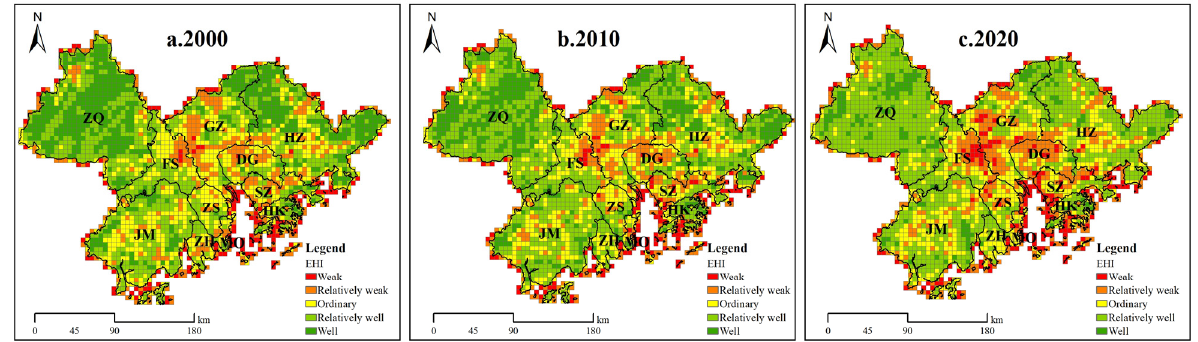
Figure 4. The spatial pattern of the EHI in the GBA, 2000–2020.